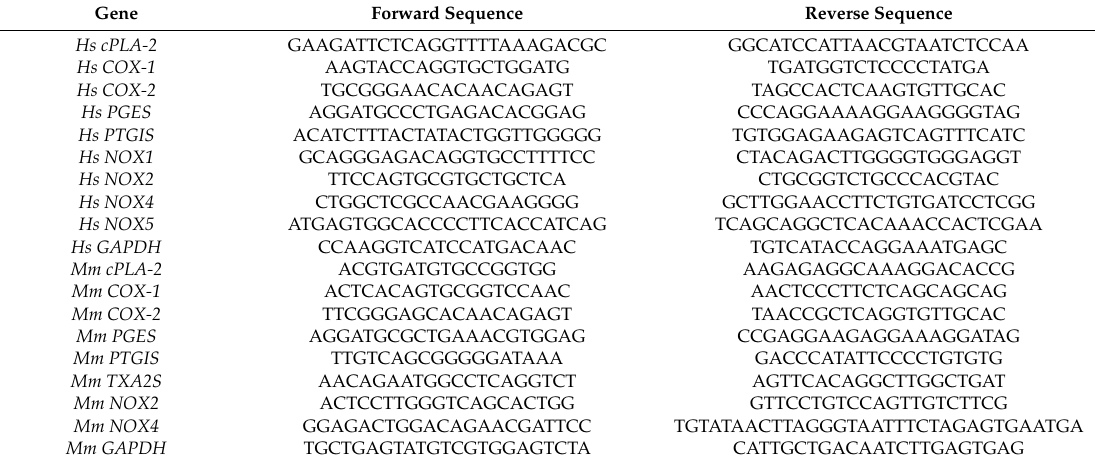
Table 1. Primer sequences for quantitative real-time PCR